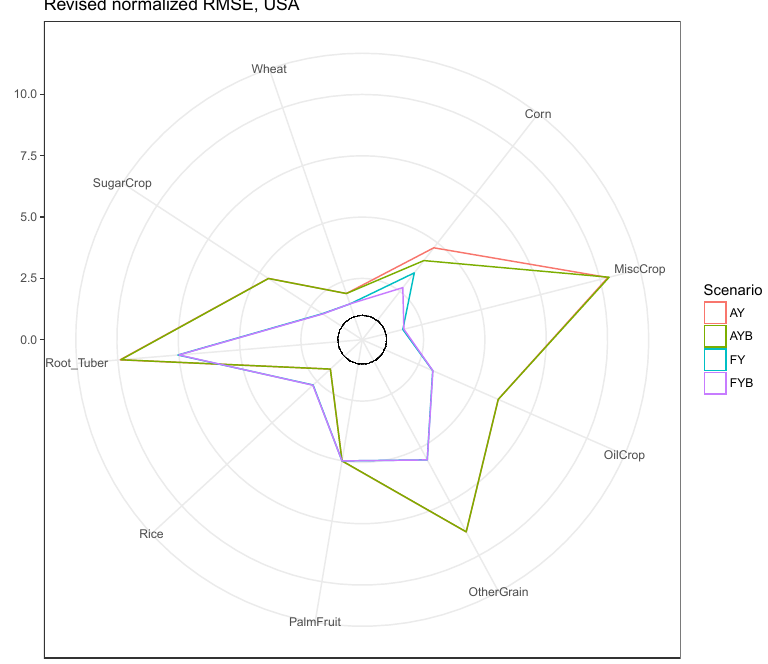
Figure 6. Revised normalized RMSE, ˆ e ij (Eq. 10), for each crop in the United States. A black circle is included for ˆ e ij = 1; ˆ e ij compares RMSE error with the standard deviation about the observed trend line for each